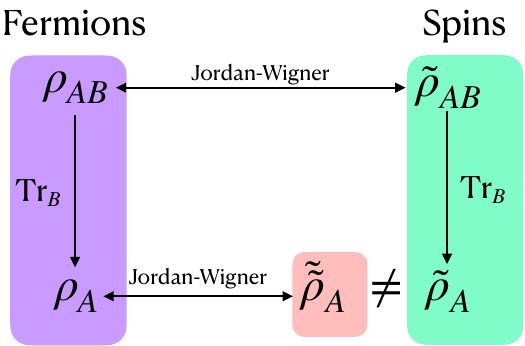
Figure 16: The mapping of the reduced state is different from the reduced state of the mapping [ 28